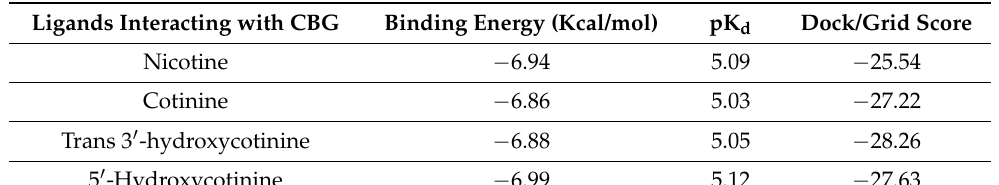
Table 4. The binding strength scores for nicotine and its metabolites in complex with corticosteroid- binding globulin (CBG). The ‘K d ’ denotes the dissociation constant. The binding energy and pK d or − log (K d ) values were calculated using X-Score. Lower (more negative) binding energy or Dock/Grid score and higher dissociation constant denote better docking.